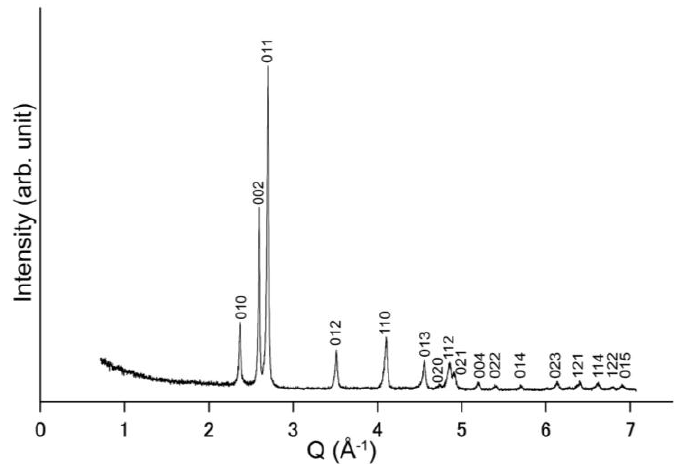
Figure 5. X-ray diffraction (XRD) pattern of the f-TiZr alloy. The Miller indices of the α-phase are shown next to the corresponding